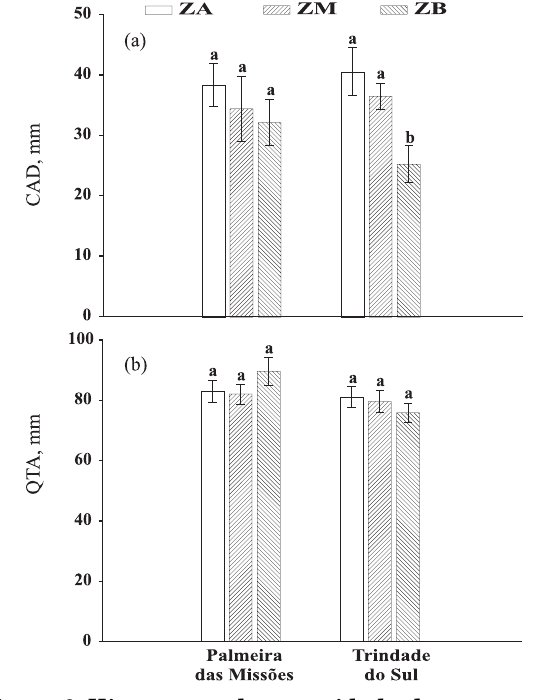
Figura 2. Histograma da capacidade de armazena- mento de água (CAD) e da quantidade total de água disponível no solo (QTA) para as três zonas de rendimento na camada 0–0,2 m, nas áreas experimentais de Trindade do Sul (TS) e de Palmeira das Missões (PM). As barras de erro correspondem ao desvio-padrão. Médias seguidas da mesma letra minúscula, na mesma área experimental, não diferem entre si pelo teste de Tukey a 5